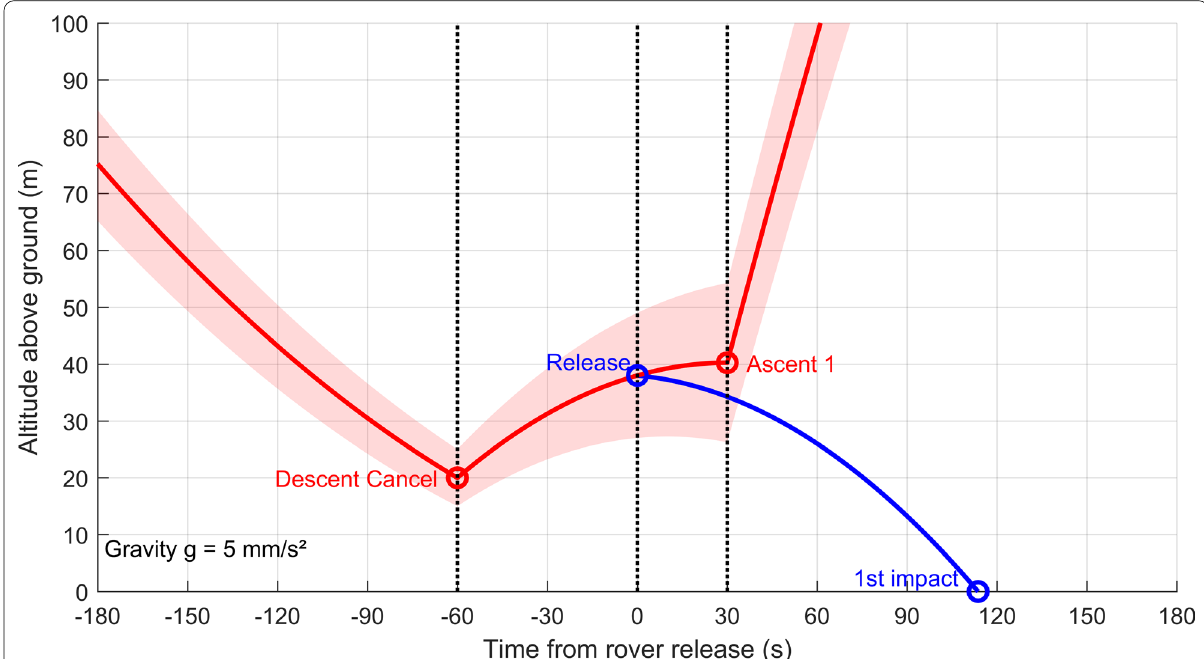
Fig. 15 Baseline delivery strategy of Rover which is released at 40 m high from the surface of Phobos. Red trajectory indicates spacecraft and blue is